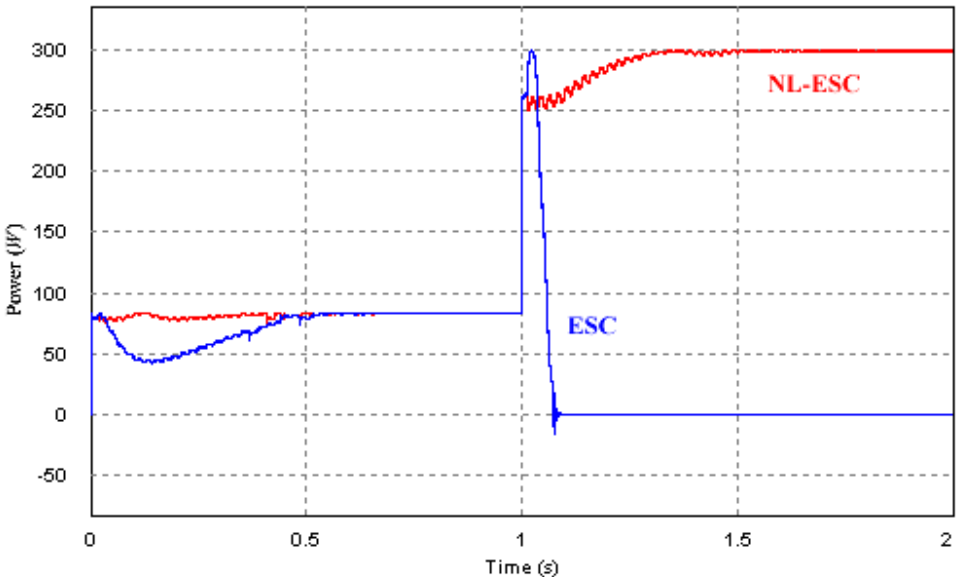
Figure 18. Transient of panel power in front an abrupt irradiance increase in NL-ESC case ( Red ) and in ESC case ( Blue